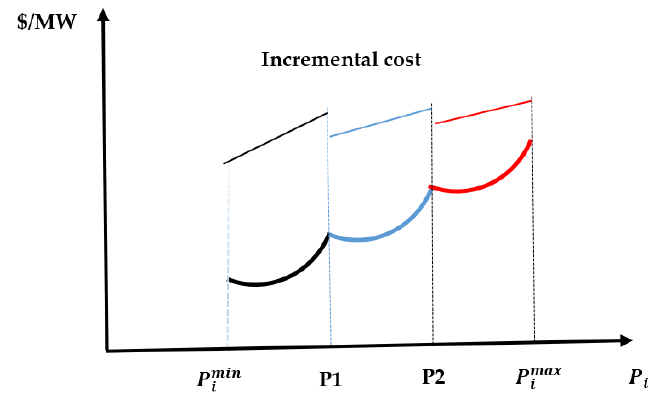
Figure 4. Piecewise quadratic and incremental cost function.